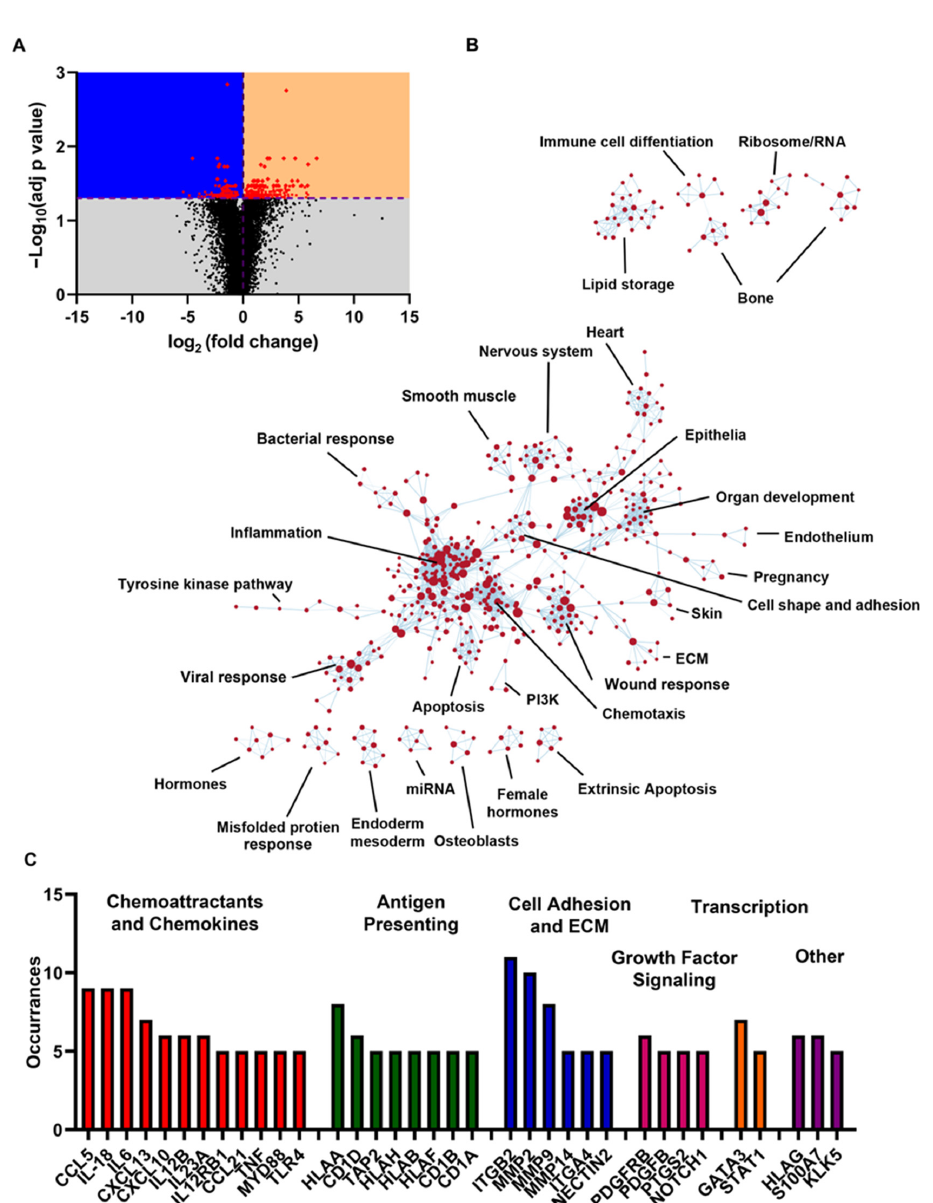
Figure 4. Passaging HBEC alters gene expression. ( A ) Volcano plot of RNAseq data comparing P0 and P2 HBECs. Purple dashed lines represent p = 0.05 and log 2 (fold change) = 0. Black dots are genes with non-significant changes. Red dots are genes with significant changes. ( B ) String analysis of enriched gene sets (c5.go.bp.v2022.1.Hs.symbols.gmt database of GO Biological Process ontology gene sets. ( C ) Most impactful genes identified by leading edge analysis of significantly enriched gene sets shown in panel B. Occurrences indicates the number of significantly enriched gene sets containing the indicated gene.